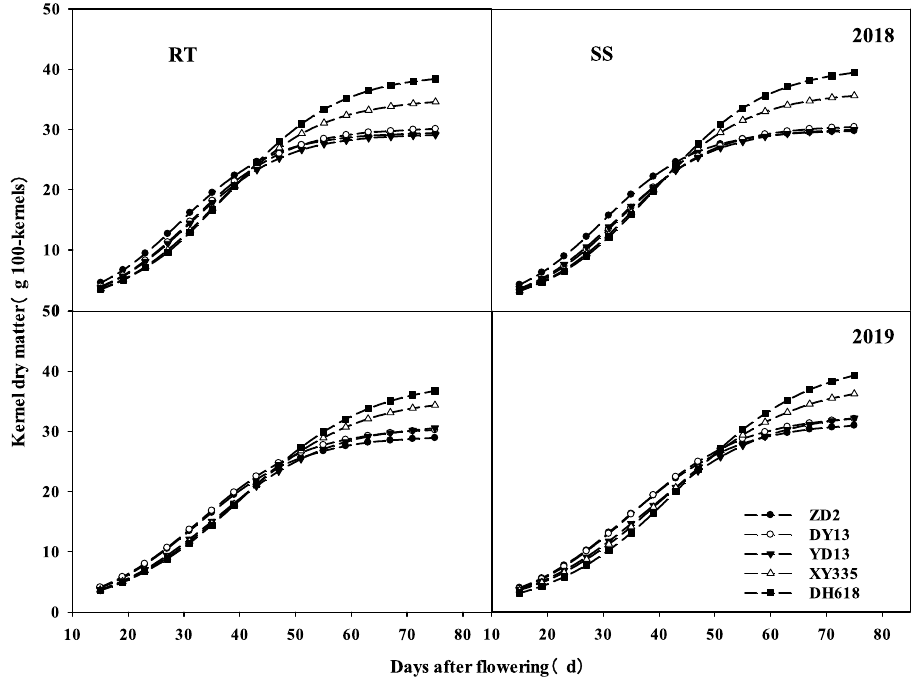
Figure 4. Effects of subsoiling tillage on the dry weight of 100 grains of maize varieties from different